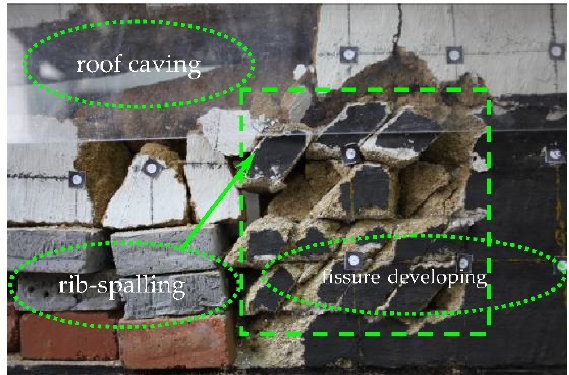
Figure 9. Development of joint and instability form the coal wall rib-spalling ( α = 60°).